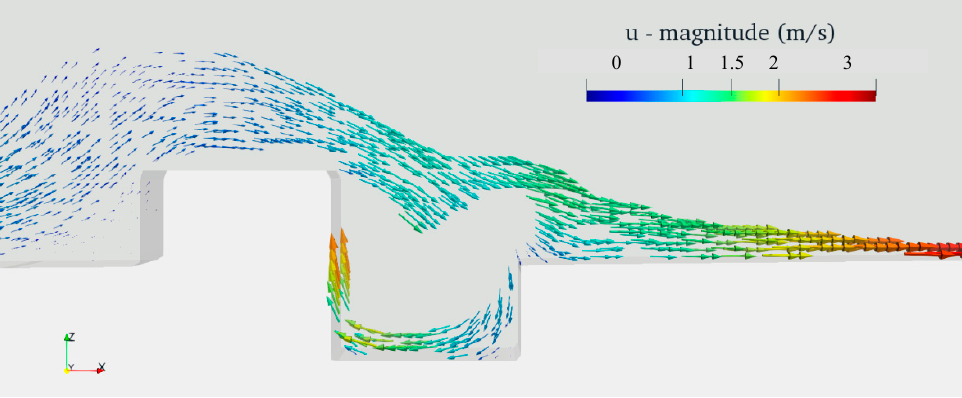
Figure 25. Current velocity vectors at t = 13.2 s for simulation Case 24 (Table 4).